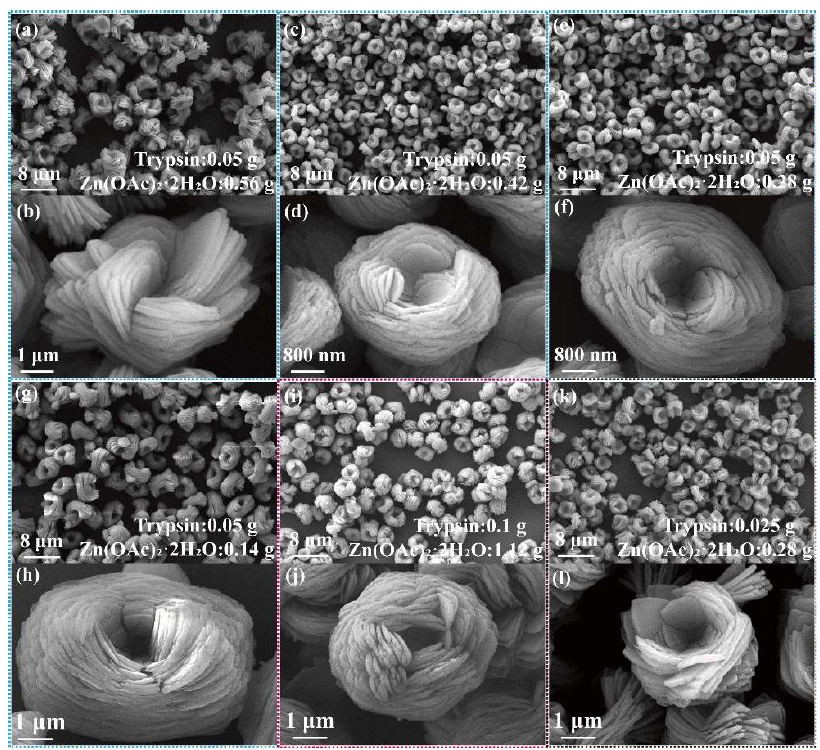
Figure 3. Effect of amount of Zn 2+ added on trypsin/Zn 3 (PO 4 ) 2 hybrid nanoflowers; the dosage of Zn(OAc) 2 ·2H 2 O was ( a , b ) 0.56 g, ( c , d ) 0.42 g, ( e , f ) 0.28 g and ( g , h ) 0.14 g. Trypsin amount was 0.05 g. The concentration of raw material is doubled ( i , j ) and halved ( k , l ).